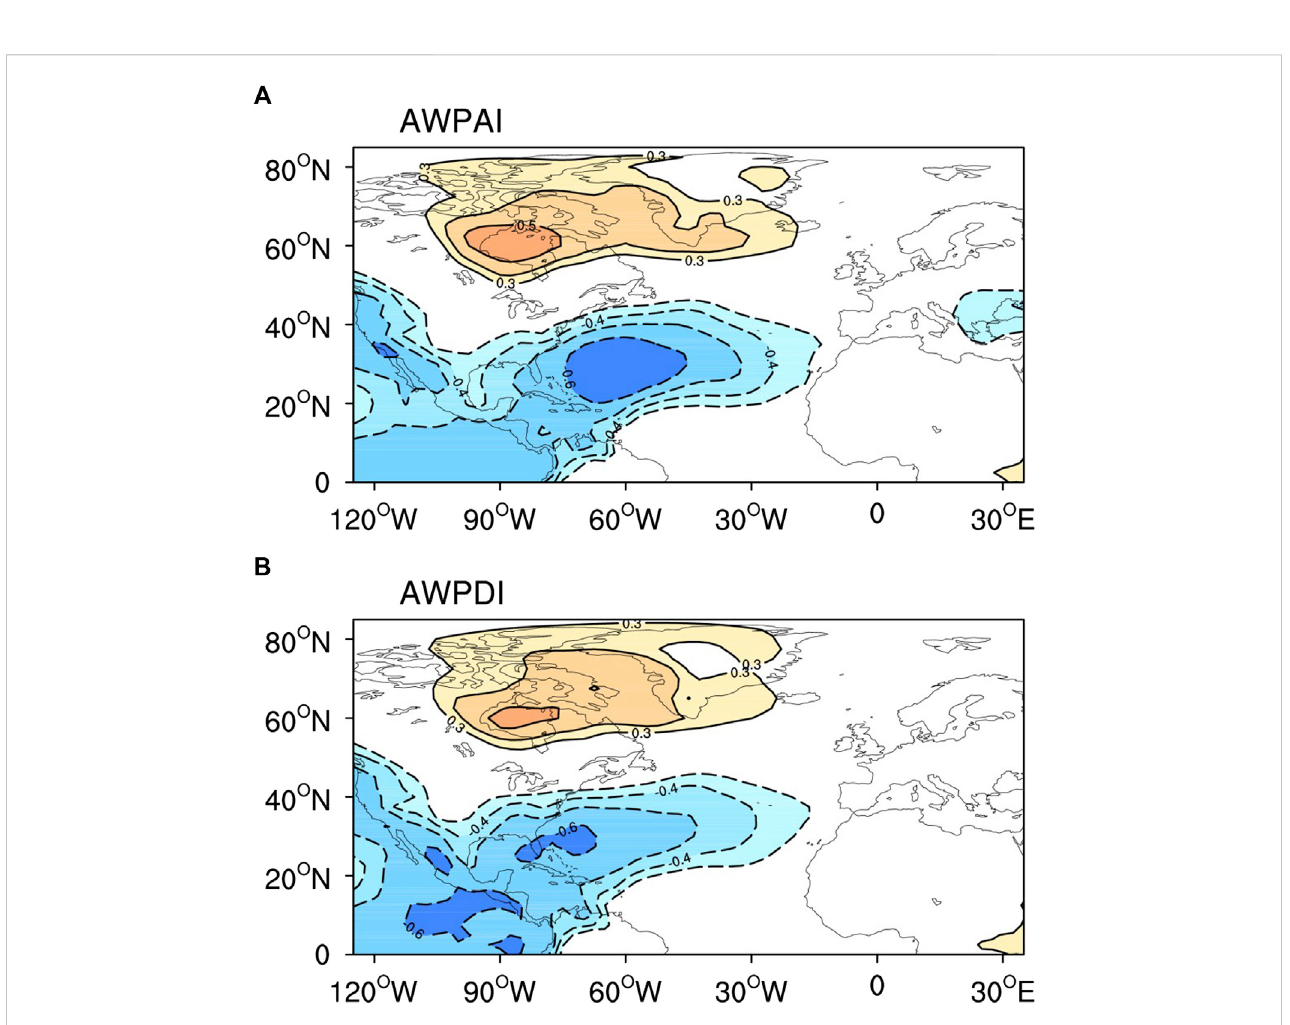
FIGURE 4 (A) Spatial pattern of DJFM-averaged sea level pressure anomalies correlated with the following MJJ AWPAI. (B) As in (A) , but with the following MJJ AWPDI. Positive (yellow) and negative (blue) SLP anomalies with correlations signi fi cant at or above the 95% con fi dence level are shaded and the contour interval is